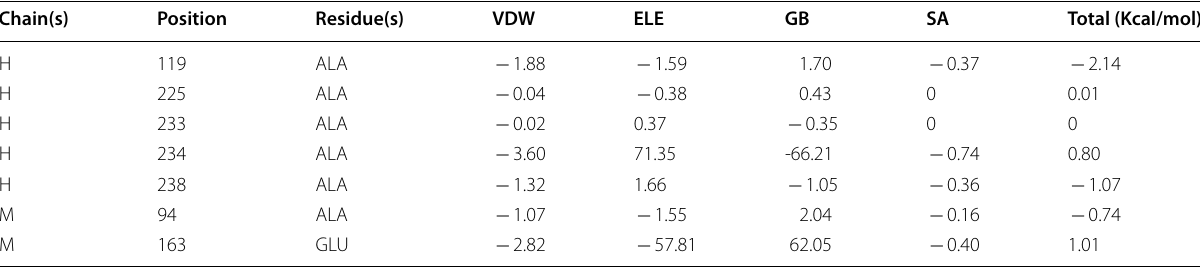
The output displays the mutated chains, residue positions, van der Waals potential, electrostatic potential, generalized born scores, solvent accessibility and the total binding energy score